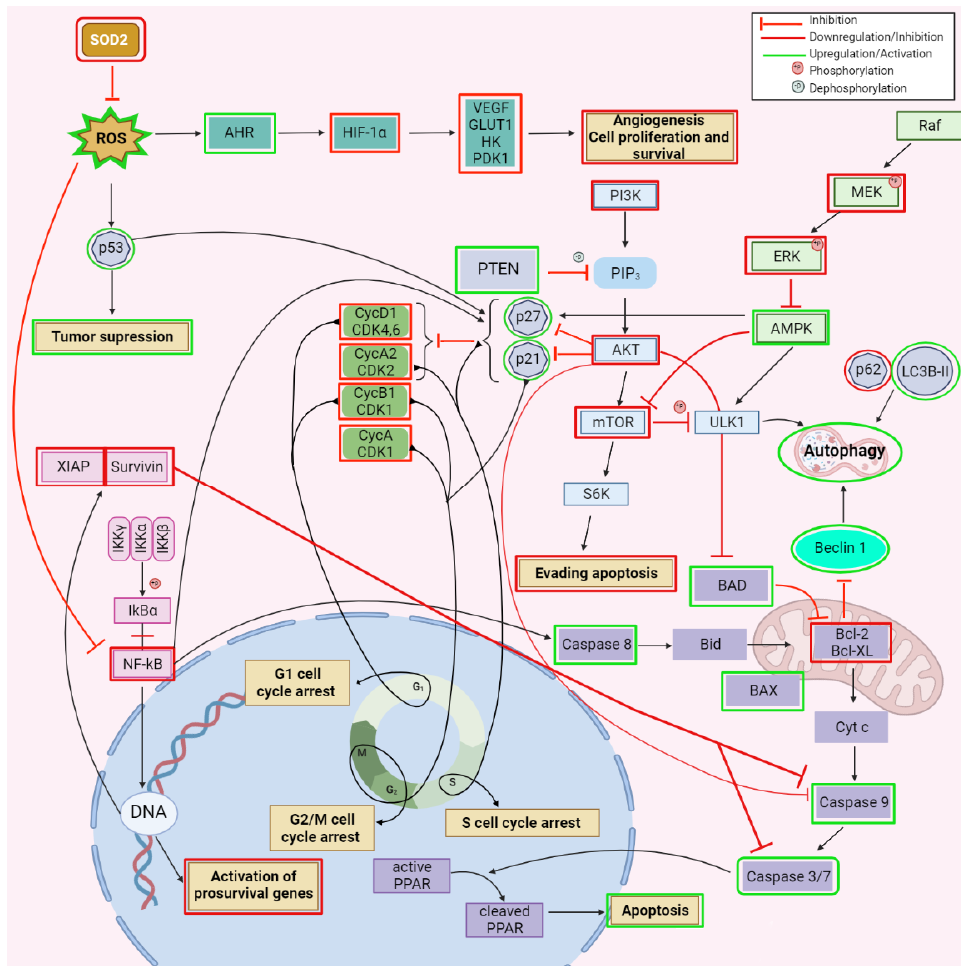
Figure 4. Schematic representation of the reported anticancer mechanisms of betulinic acid; key signaling pathways targeted. Created with BioRender.com (accessed on 23 June 2022).